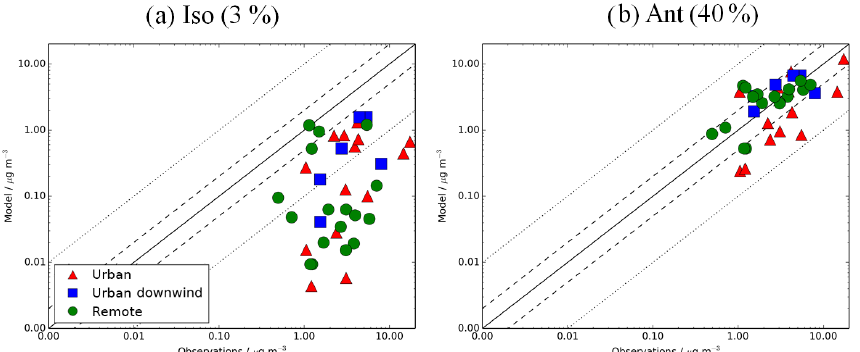
Figure 12. Simulated vs. observed SOA (µgm − 3 ) for the following sensitivity simulations: (a) Iso (3%) and (b) Ant (40%), described in Table 2. Observations for the time period 2000–2010 are classified as urban (red triangles), urban downwind (blue squares), or remote (green circles). Observed OOA is assumed to be comparable to simulated SOA. The 1 : 1 (solid), 1 : 2 and 2 : 1 (dashed), and 1 : 10 and 10 : 1 (dotted) lines are indicated. Model–observation statistics for SOA are shown in Table